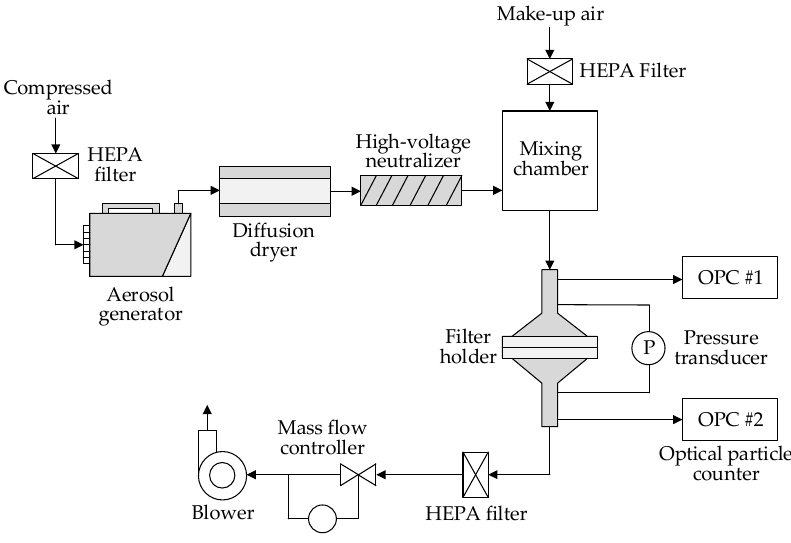
Figure 1. Schematic of filtration test setup.